Question: Which visualization type does this figure use?
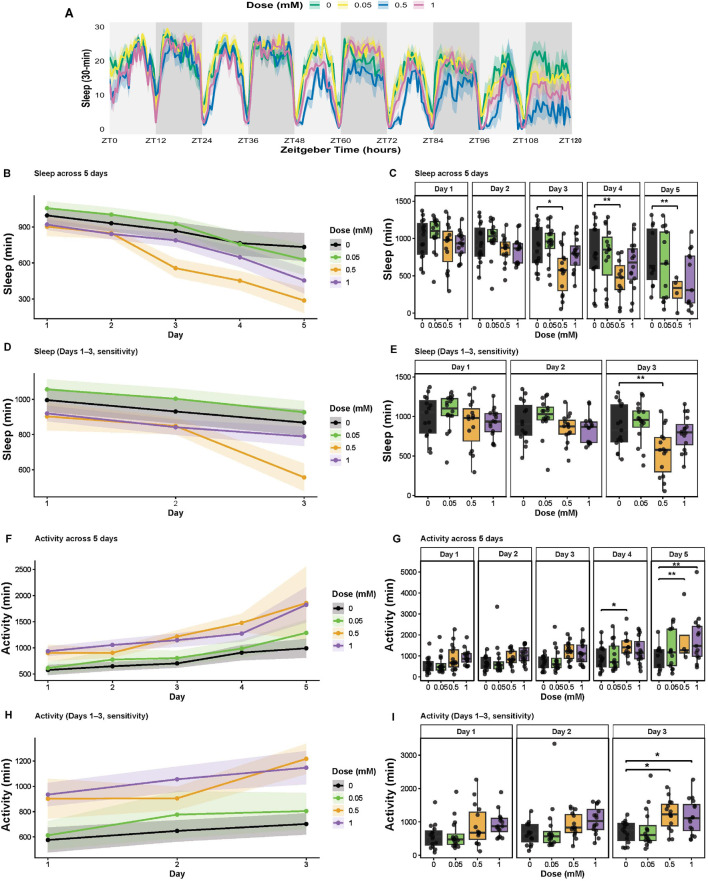
Answer: box